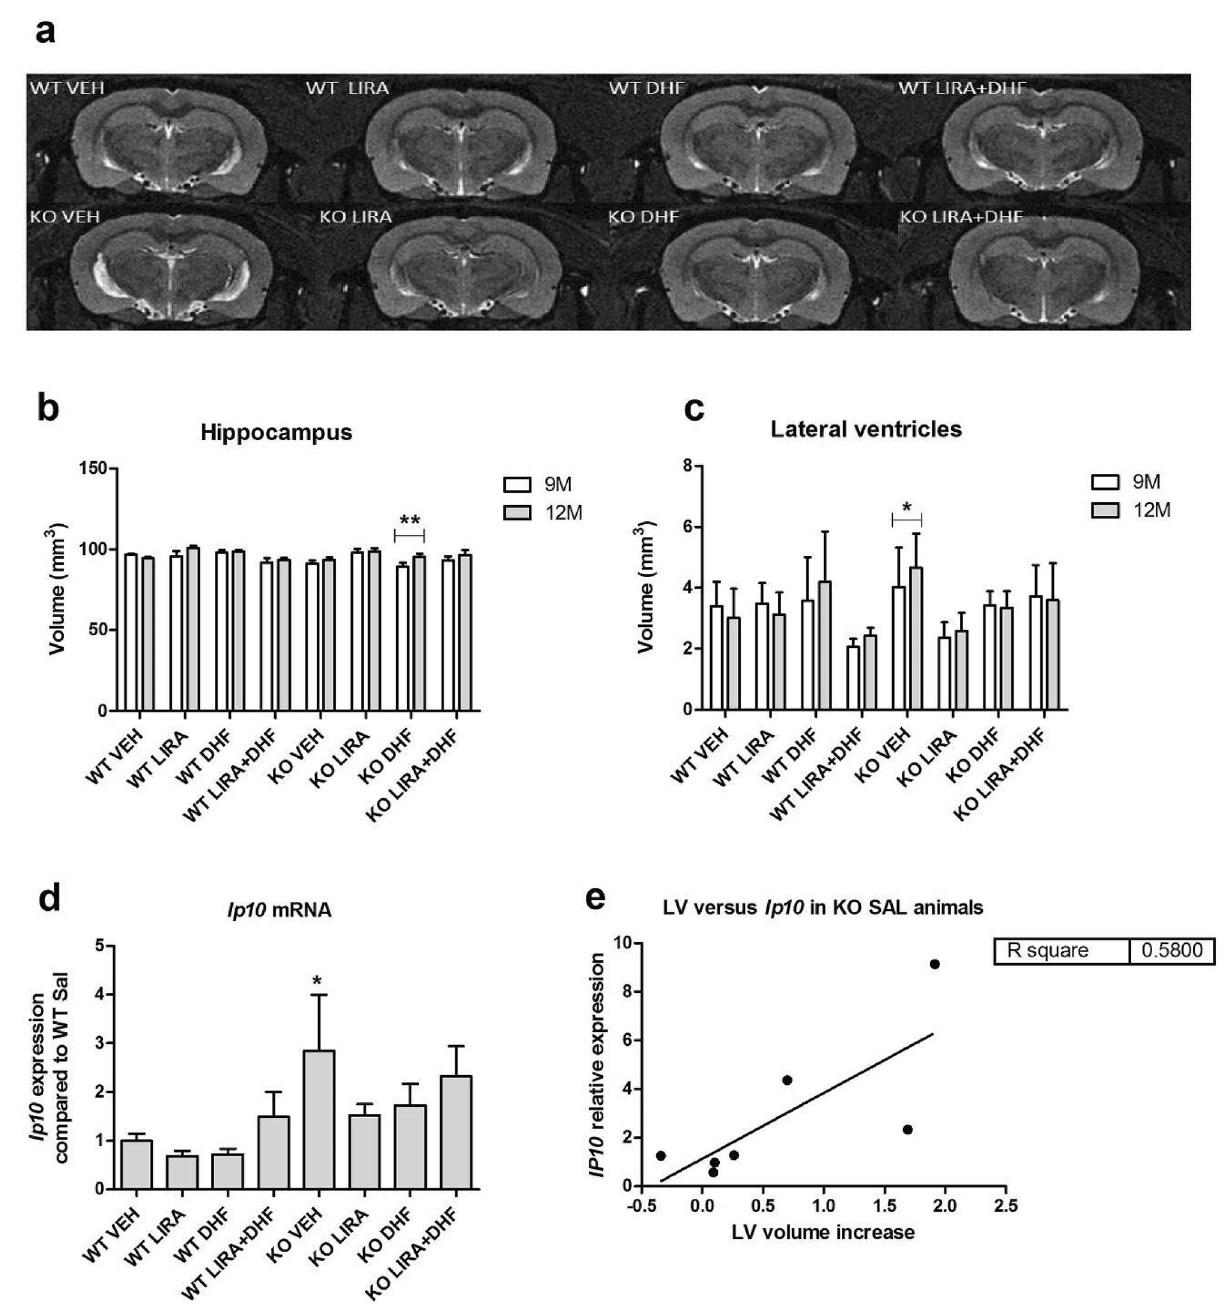
Figure 6. Wfs1 KO rats show lateral ventricles enlargement ( a ) Representative T2-weighted MR images of the hippocampus and lateral ventricles of WT and Wfs1 KO animals treated with liraglutide (LIRA), 7,8- DHF (DHF) or liraglutide and 7,8-DHF (LIRA + DHF). Quantitative MRI analysis of ( b ) hippocampus and ( c ) lateral ventricles. Gene expression analyses of hippocampus were performed to measure ( d ) Ip10 mRNA levels. ( e ) Correlation between lateral ventricles volume and Ip10 mRNA expression. Wfs1 KO rats show lateral ventricles enlargement ( a , c ), elevated inflammatory marker Ip10 levels ( d ) and moderate correlation between inflammatory marker I p10 and lateral ventricles enlargement ( e ). Treatment with liraglutide, 7,8-DHF or with liraglutide and 7,8-DHF combination prevented from ventricular enlargement and hippocampus from cellular stress. Volumes were manually traced by an observer blinded to the genotypes of the rats from T2-weighted MR images using ITK-SNAP software. The MRI data were compared using repeated measures ANOVA followed by Bonferroni post hoc tests; *p < 0.05; **p < 0.01 and gene expression data were compared using factorial ANOVA followed by Fisher’s LSD tests; *p < 0.05. The data are presented as the mean ± SEM, n = 5–8 per